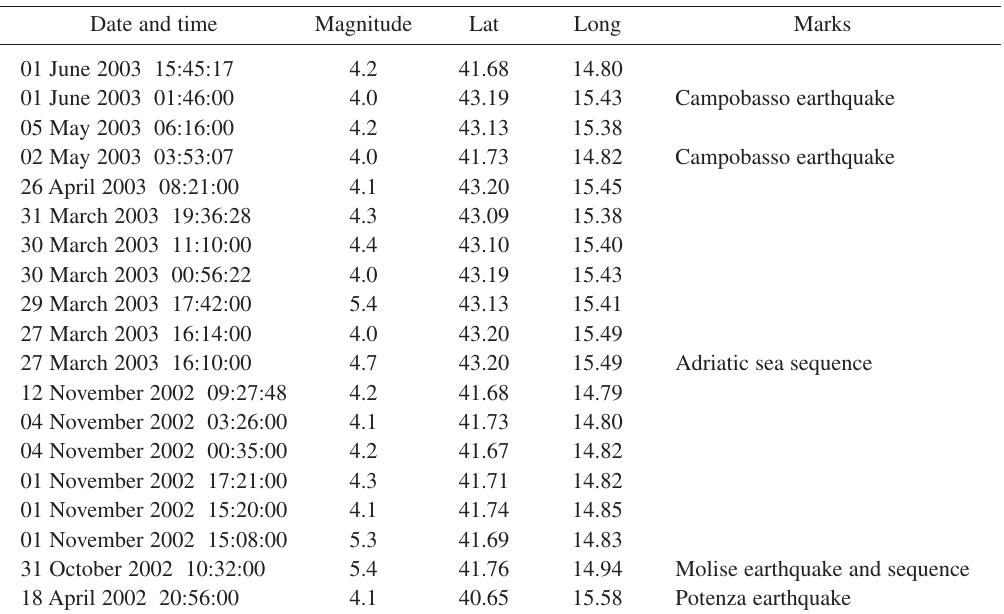
Table I. List and geographic location of earthquakes with M ≥ 4.0 occurred in the target area of Central Italy during 2002 and 2003. Source: INGV (2004). Date and time Magnitude Lat Long